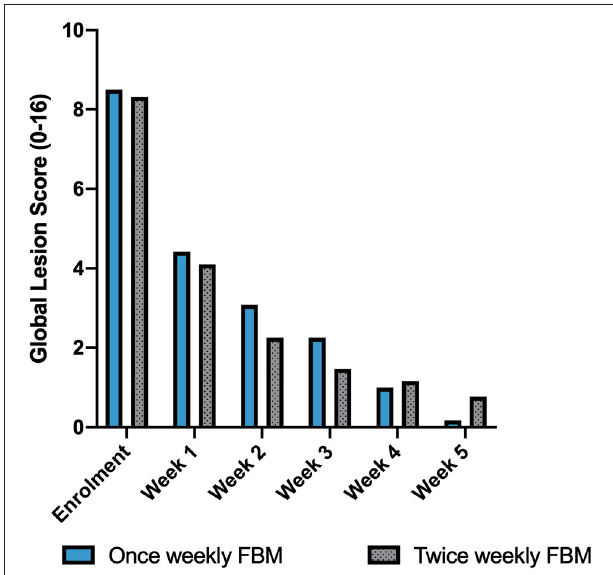
FIGURE 1 | Global lesion score per week of study, in comparison with those reported for twice weekly FBM application from previous published study (15).